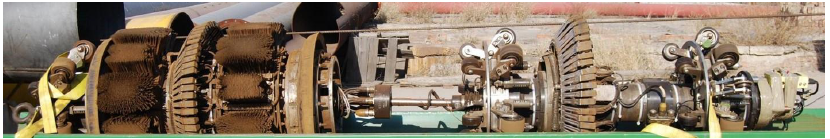
Figure 1. A MFL tool, comprising three main sections: a drive section at the front of the tool, a central magnetizer section and a data logger situated towards the rear of the tool.